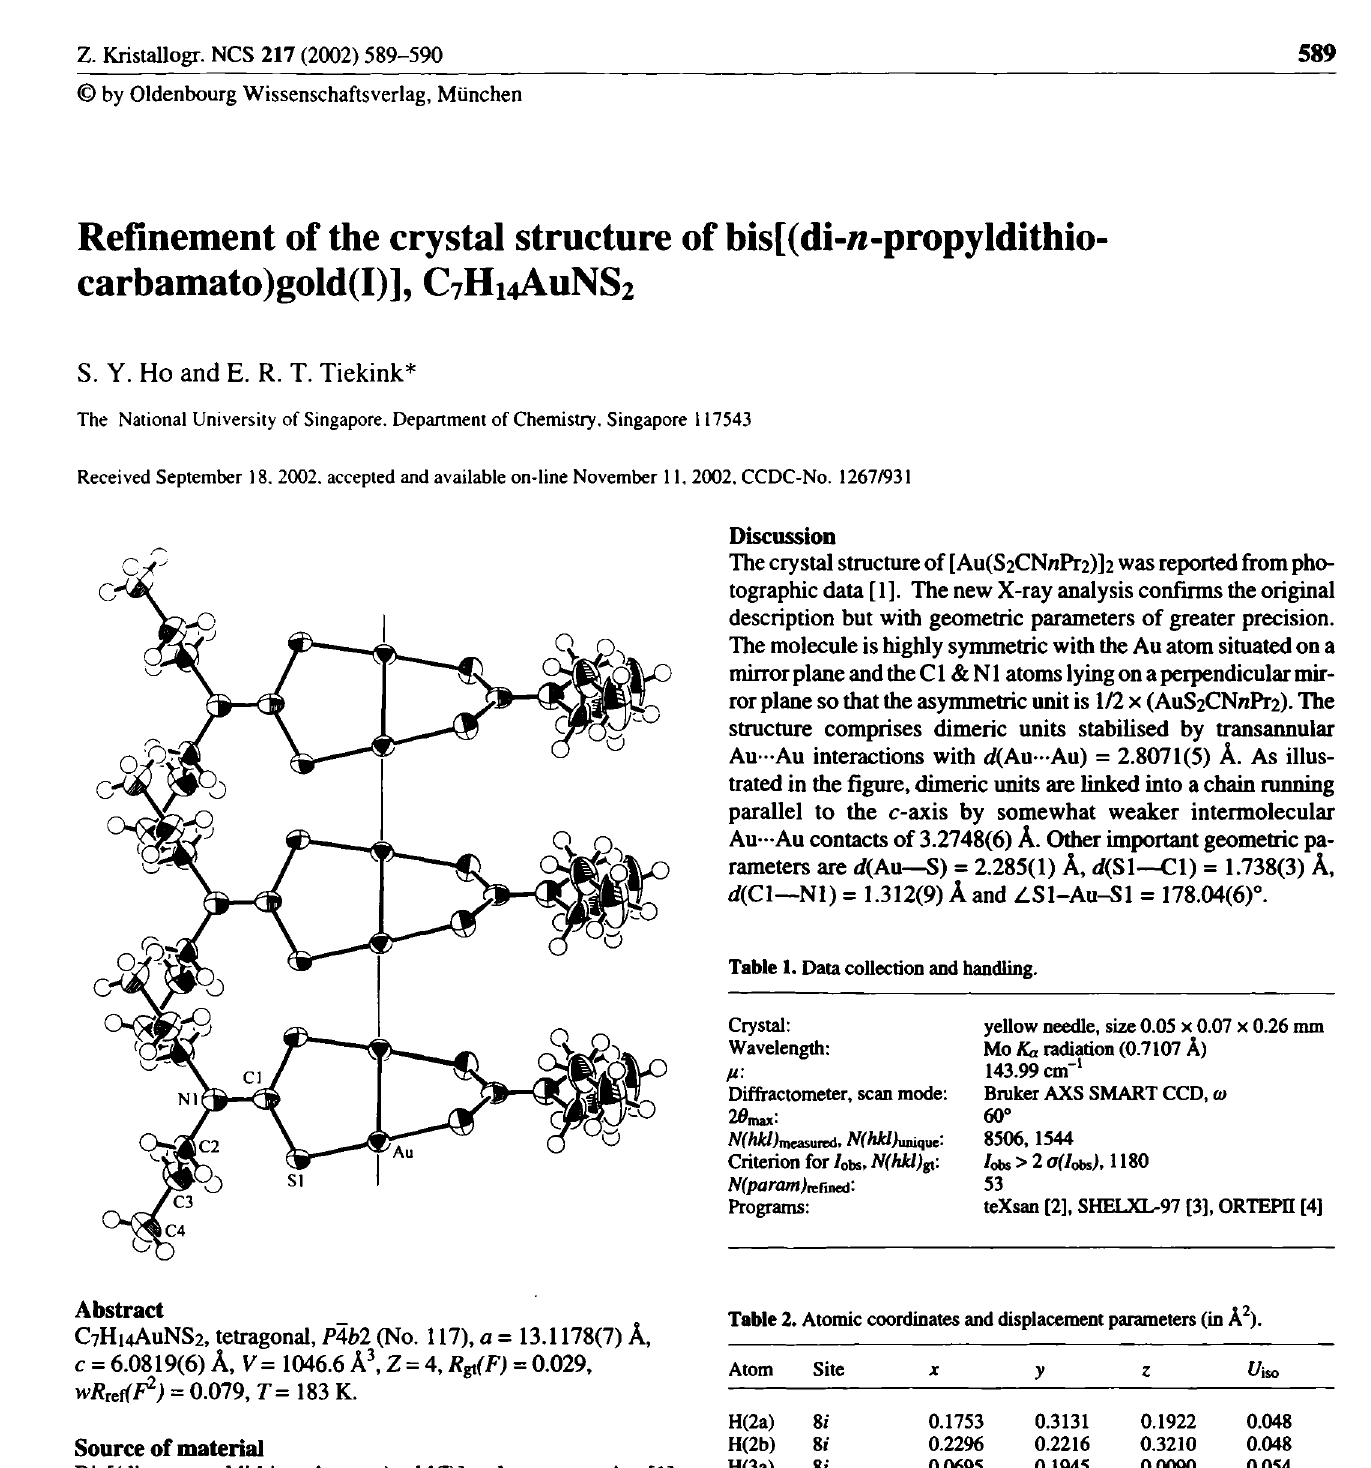
Table 2. Atomic coordinates and displacement parameters (in Â 2